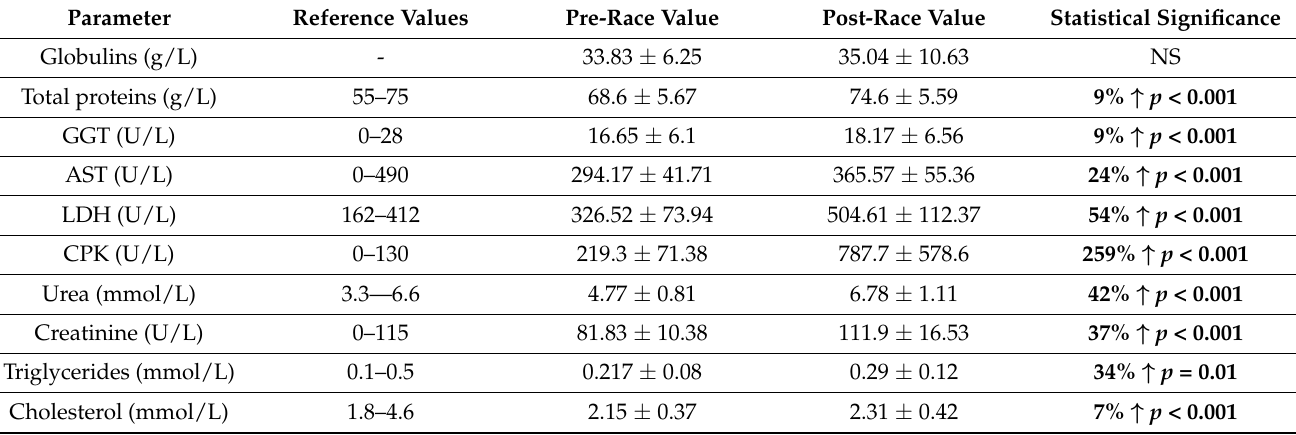
Table 3. Values of serum biochemical parameters in 23 horses before and after the endurance race.